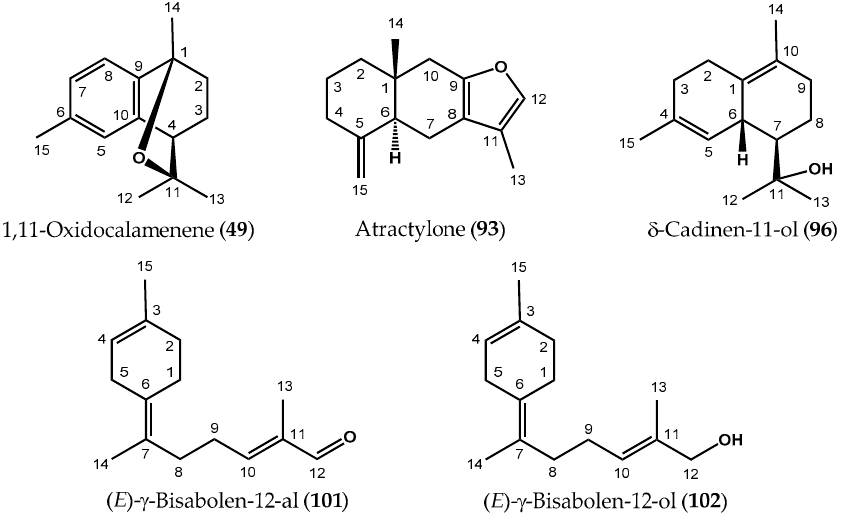
Figure 1. Structures of isolated compounds 49 , 93 , 96 , 101 and 102 . Table 1. 13 C-NMR data of compounds 49 , 93 , 101, and 102